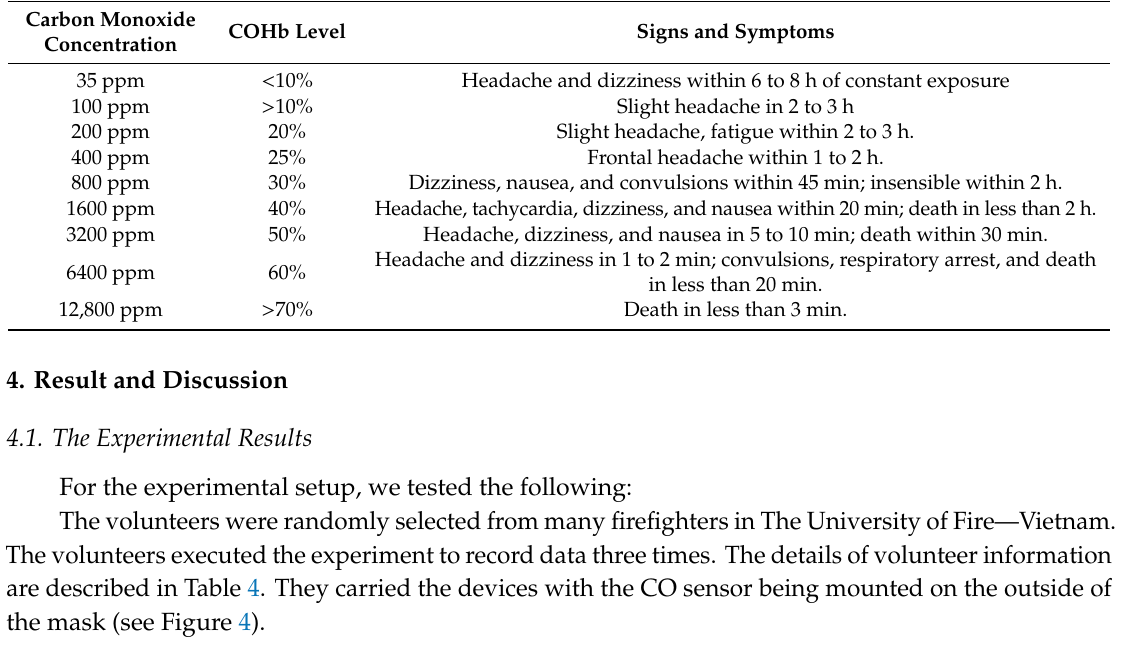
Table 3. Carbon monoxide concentrations, COHb levels, and symptoms 26 .